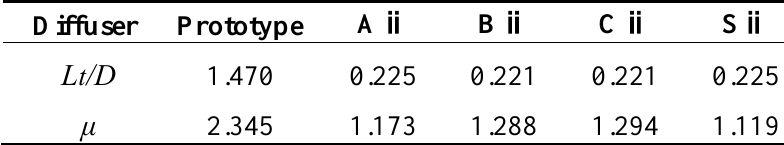
Table 1. Parameters of wind-lens